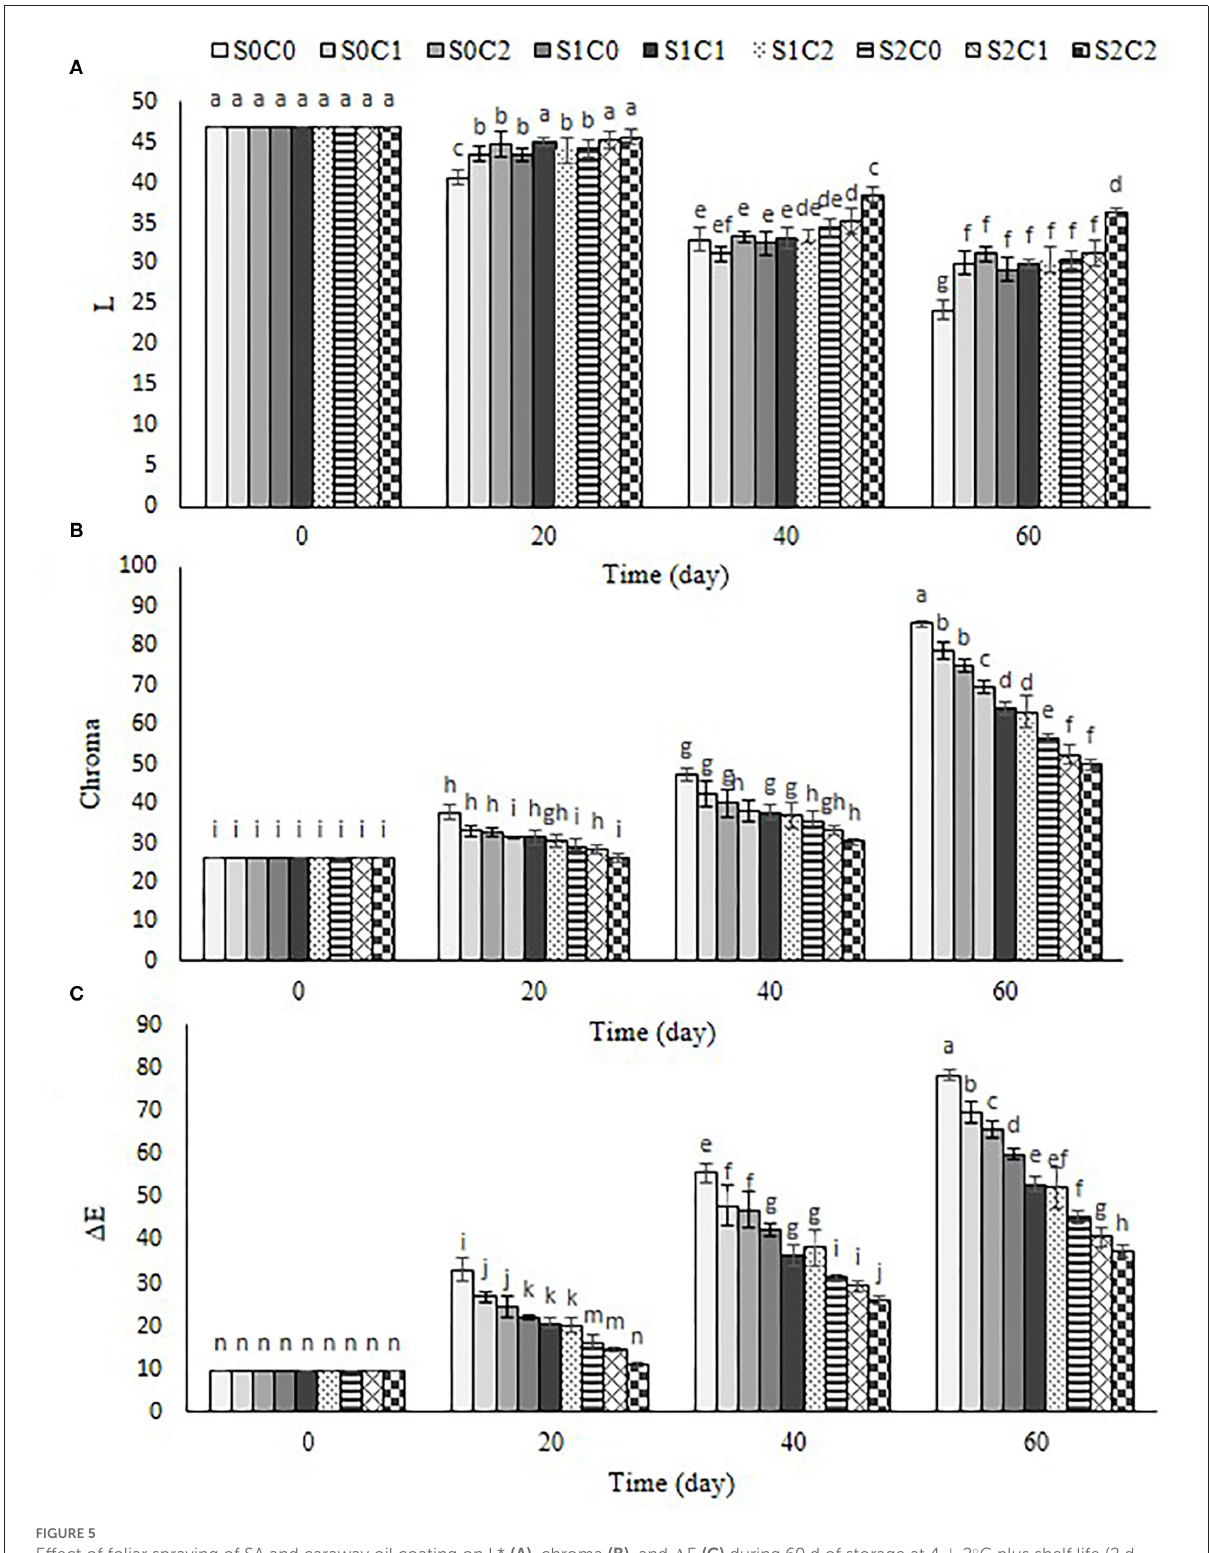
FIGURE5 Effect of foliar spraying of SA and caraway oil coating on L* (A) , chroma (B) , and 1 E (C) during 60 d of storage at 4 ± 2 ◦ C plus shelf life (2 d, 20 ◦ C). S0C0: control, S0C1: 0.3% caraway oil, S0C2: 0.6% caraway oil, S1C0: 1.5mM Salicylic acid, S1C1: 1.5mM Salicylic acid + 0.3% caraway oil, S1C2: 1.5mM Salicylic acid + 0.6% caraway oil, S2C0: 3mM Salicylic acid, S2C1: 3mM Salicylic acid + 0.3% caraway oil, S2C2: 3mM Salicylic acid + 0.6% caraway oil. Values represent mean ± S.D of three replications. Different letters indicate significant differences at the 5% level according to the Duncan